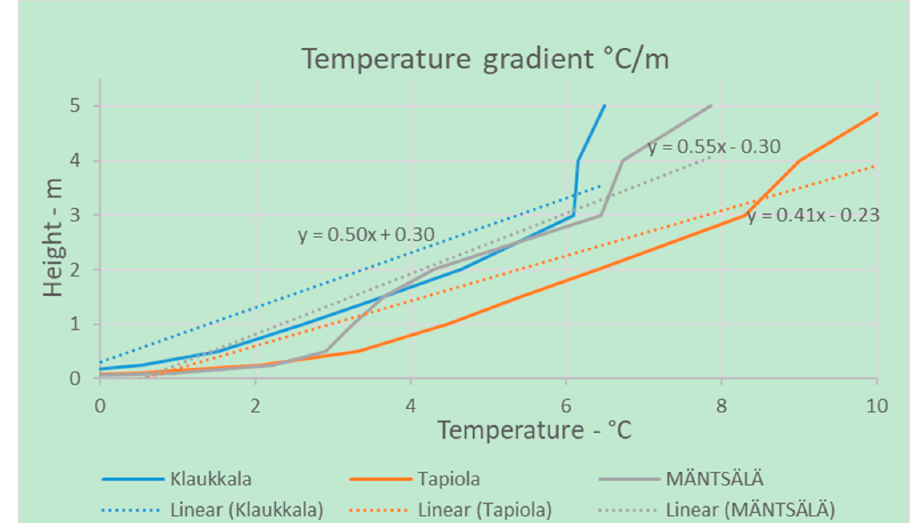
Figure 12. Air stratification measurement results of three ice arenas in Finland.